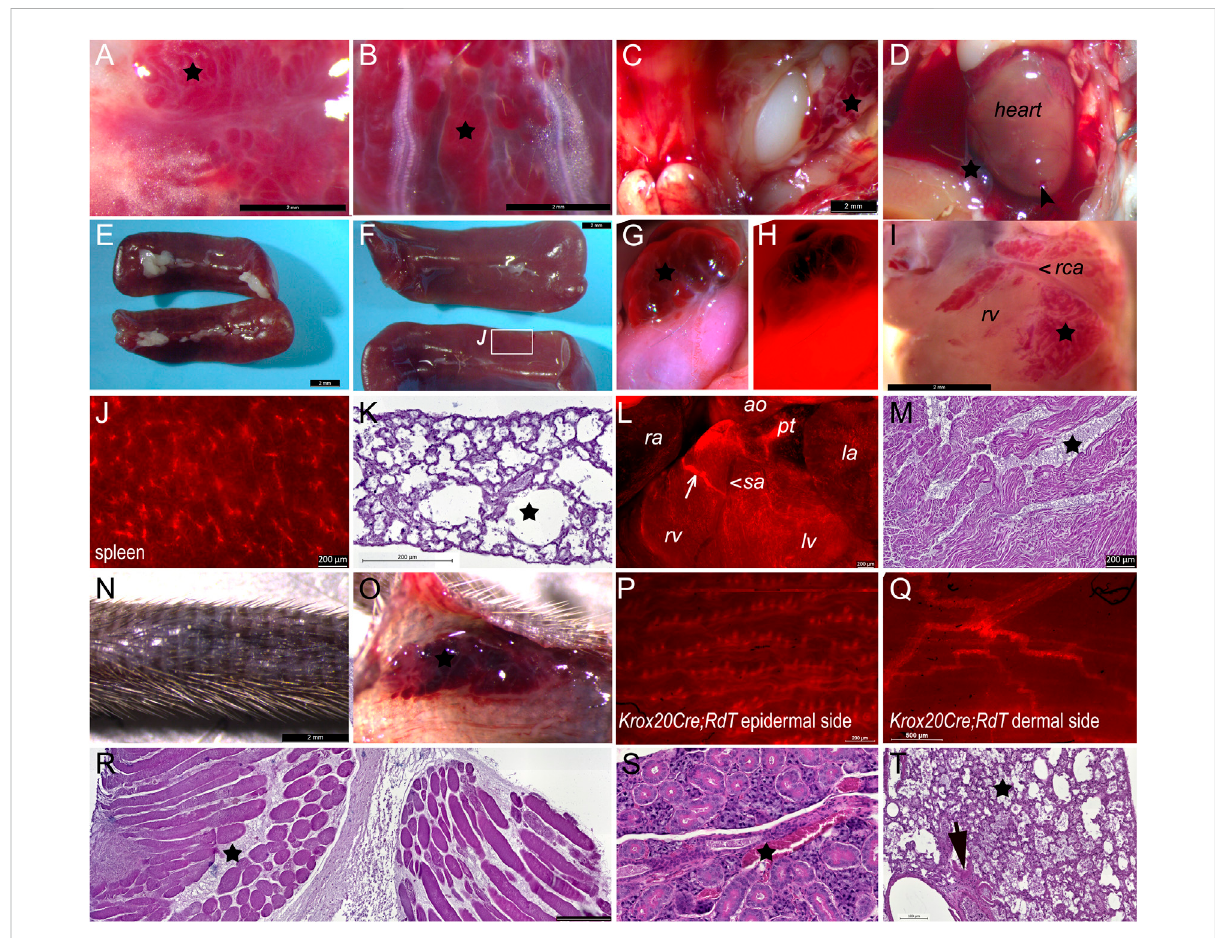
Anatomy and histology of vascular anomalies in Krox20-Cre +/ ° ; Pik3ca H1047R/+ adult mutant mice. (A) Subcutaneous vascular anomaly (star), epaxial ( longissimus dorsi ) muscle. Bars A – I: 2 mm. (B) Subcutaneous vascular anomaly (star), quadriceps. (C) Vascular anomalies (star) around left gonad. (D) Mutant heart, small vascular anomaly at apex (arrow) and an extracardiac anomaly (star). (E) Control littermate spleens of those in (F) . (F) Krox20-Cre +/ ° ; Pik3ca H1047R/+ ; RdT +/ ° spleens, same scale as (E). Boxed region enlarged in (J) . (G,H) Vascular tumor (star) around gonad from different mouse than in (C) , Krox20-Cre +/ ° ; Pik3ca H1047R/+ ; RdT +/ ° . The fl uorescent fi broblasts in gonad and lesional septa in (H) had expressed Krox20 and thereby, constitutively active Pik3ca. (I) Intracardiac vascular anomalies (star) were present in all mutant adults examined. (J) Krox20- Cre +/ ° ; Pik3ca H1047R/+ ; RdT +/ ° spleens had numerous fl uorescent rami fi cations consistent with reticular fi bers, peripheral nervous or perivascular elements. Bar, 200 µm. (K) Mutant femoral bone marrow in an adult mouse that had spontaneously died with multiple vascular anomalies (star) was hypocellular with increased density of vascular sinuses rather than adiposity. Bar, 200 µm. (L) Heart from a Krox20-Cre +/ ° ; Pik3ca H1047R/+ ; RdT +/ ° mouse showing recombined cells in a fi ne meshwork throughout the myocardium of all chambers with increased density in the ventral pulmonary trunk and strong expression in the outer wall of a sympathetic nerve (arrow). Bar, 200 µm. (M) Typical histology of vascular lacunae (star) in the ventricular wall. Bar,200 µm. (N,O) Subcutaneous vascular tumor(star)oftailof Krox20-Cre +/ ° ; Pik3ca H1047R/+ mouse.Bar,2 mm. (P) Externalviewof lineage-tracedmutant Krox20-Cre +/ ° ; Pik3ca H1047R/+ hairyskin.Fluorescent,lineage-tracedcellshavingonceexpressedKrox20arevisibleatthebase ofeachhairfollicleandinthevascularpericytesofcapillariesunderlyingthem.Bar,200 µm. (Q) Internalviewoflineage-tracedmutanthairyskin.The panniculus carnosus muscle had expressed Krox20 (striations) and the peripheral nerves express Krox20Cre -driven Tomato even more strongly in their myelinating Schwann cells. Bar, 0.5 mm. (R) Vascular lacunae (star) disrupt the organization of muscle bundles and their external connective tissues in a Krox20-Cre +/ ° ; Pik3ca H1047R/+ mutant thigh. Bar, 200 µm. (S) Disrupted vascular structures (star) were also present in the Krox20-Cre +/ ° ; Pik3ca H1047R/+ mutant salivary gland. (T) A profusion of small vascular sinuses (star) were enlarged and necrosis was visible (arrow) in the Krox20- Cre +/ ° ; Pik3ca H1047R/+ liver. Bar = 100 µm. ao, aorta; la, left atrium; lv, left ventricle; pt, pulmonary trunk; ra, right atrium; rca, right coronary artery; rv, right ventricle, sa, septal artery. Stars, vascular